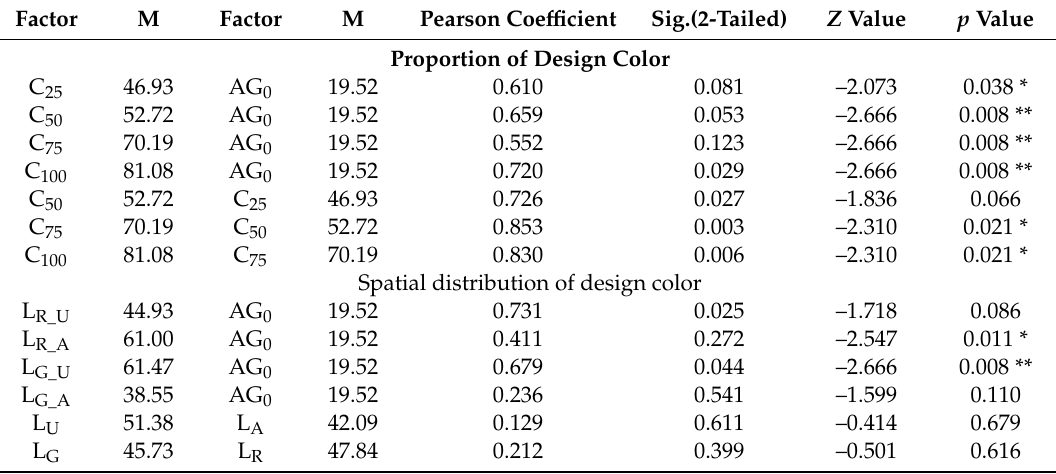
Table 3. Comparison of all green and simulation landscapes on the di ff erence of color proportion and spatial distribution with Wilcoxon signed rank test.